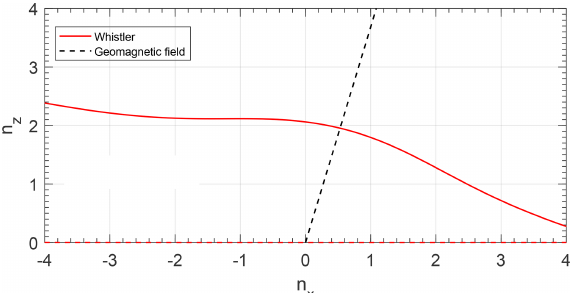
Figure 9. The refractive-index surface at 120km. Red line shows a slice of the refractive-index surface at n y = 0 of the whistler mode, calculated for f = 119kHz at the altitude of h = 120km. Black dash line shows the direction of the geomagnetic